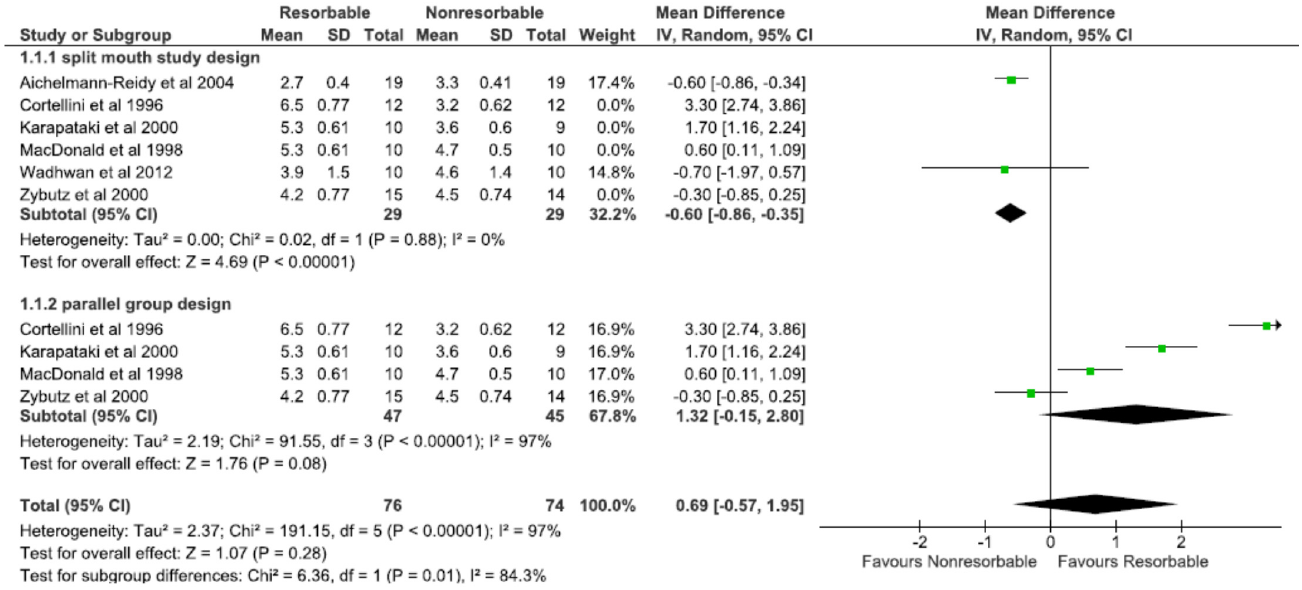
Figure 5. Subgroup analysis of probing pocket depth (PPD) at all intervals (6–12 months).